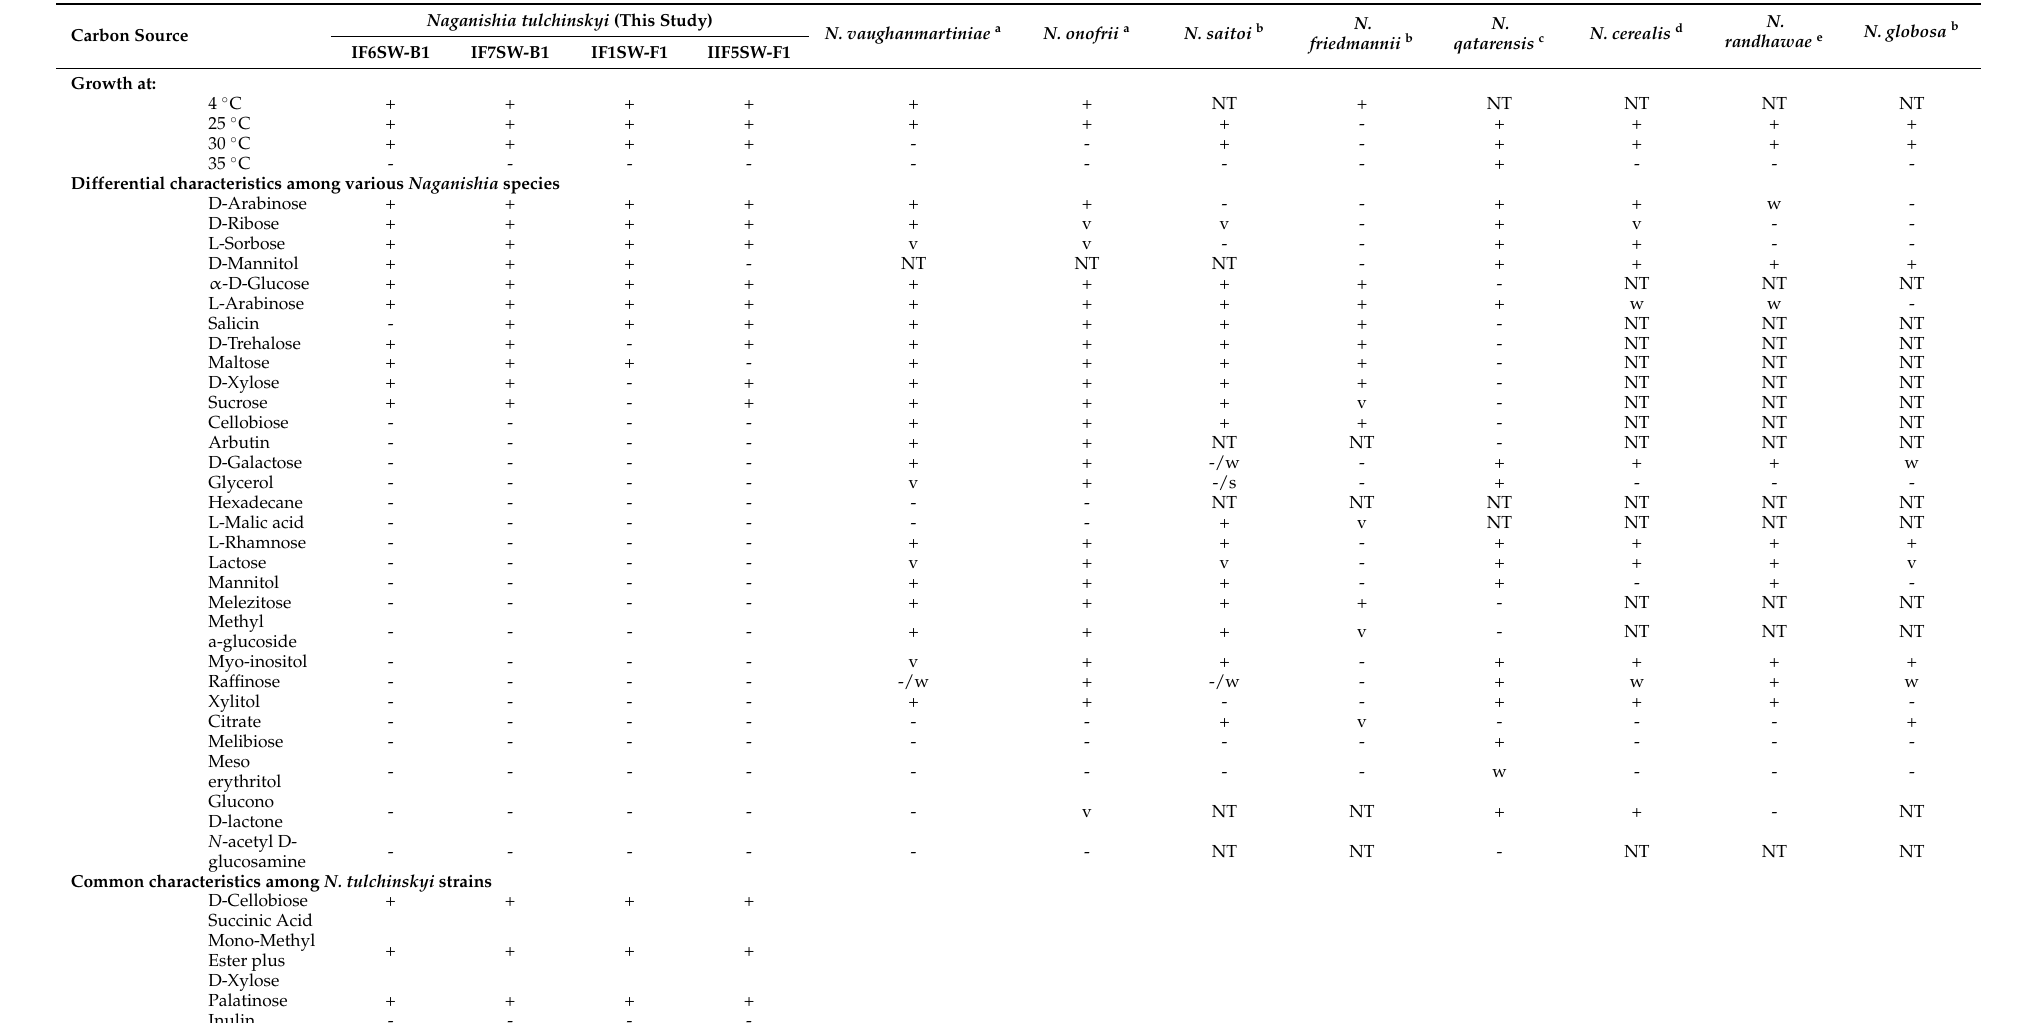
Table 3. Physiological characteristics of Naganishia tulchinskyi and closely related